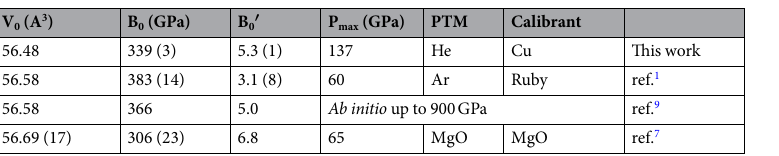
Table 1. Ambient volume V 0 , bulk modulus B 0 , first derivative of bulk modulus B 0 ′ , maximum pressure reached, P max , pressure transmitting medium (PTM) and